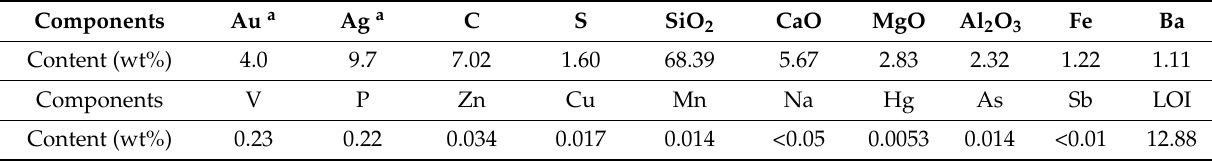
Table 1. Chemical composition analysis results of the raw ore.